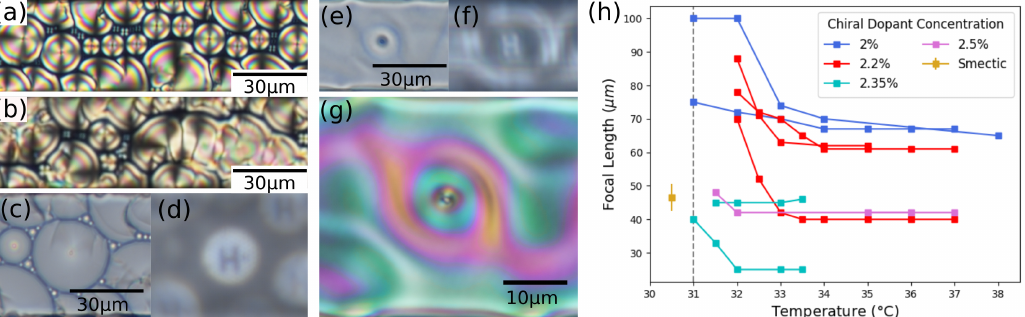
Figure 2. Lenses in smectic and cholesteric LC defects. ( a , b ) Smectic FCDs viewed between crossed polarizers. ( b ) Disrupted focal conic domains in smectic due to chirality. ( c ) Focal conic domain viewed with bright-field microscopy and ( d ) the letter H focused by it, 43 µ m above the FCD plane. ( e – g ) Circular cholesteric domain, ( e ), in bright-field microscopy with ( f ) the letter H focused by it, 50 µ m above the lens plane, and ( g ) viewed between crossed polarizers. ( h ) Focal length vs. temperature. Points connected by lines represent experiments where the sample was cooled down from the cholesteric into the smectic phase. The transition temperature between cholesteric and smectic is indicated. Colors represent different concentration of chiral